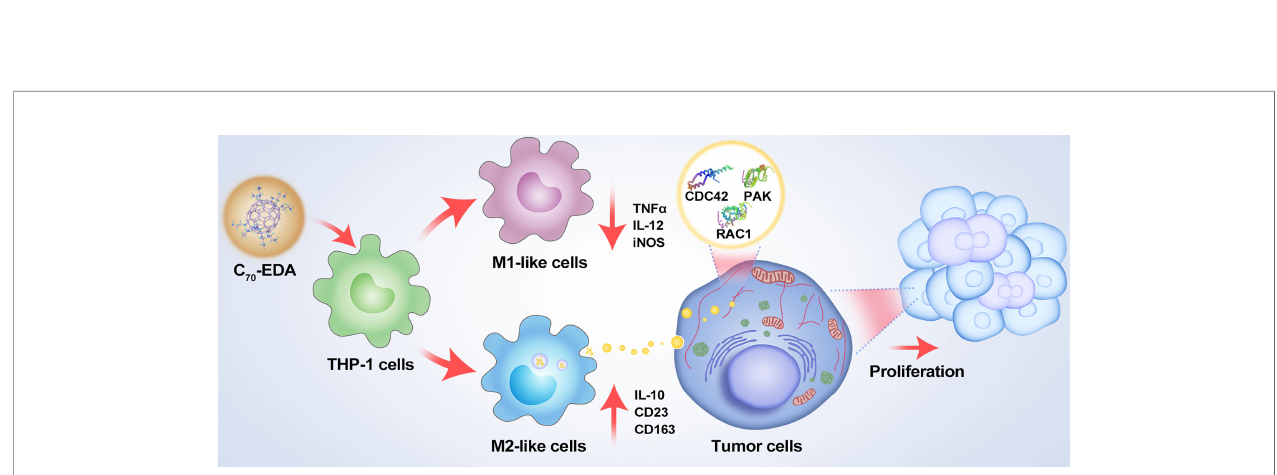
FIGURE 5 | Schematic showing the mechanisms of potential resistance to antineoplastic therapy by C 70 -EDA triggering of THP-1 monocytes to the M2 phenotype and further promoting tumor proliferation by M2-like monocyte-derived